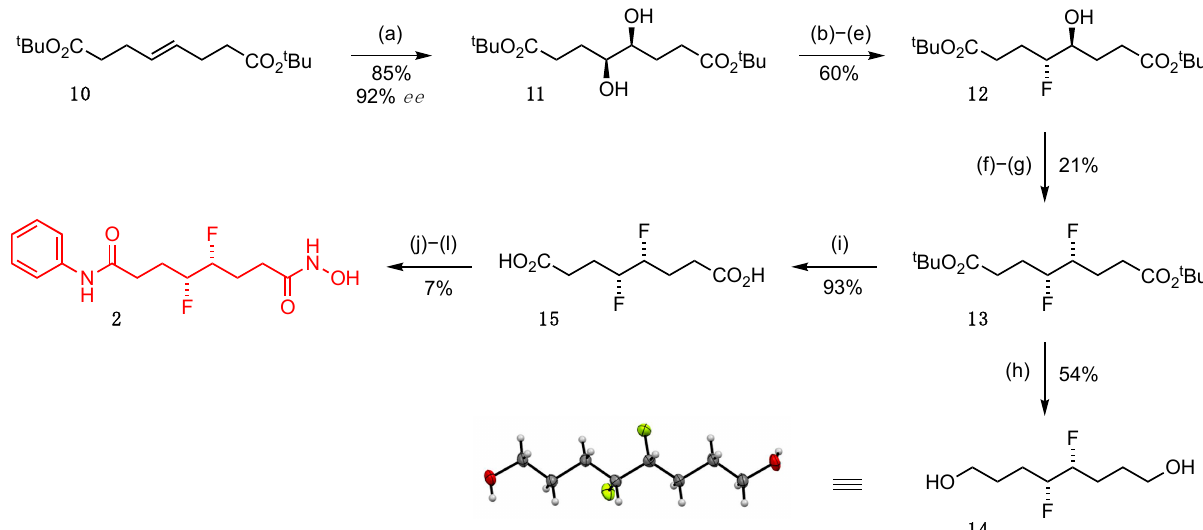
Scheme 1. Synthesis of threo -difluorinated SAHA analog 2 . Reagents and conditions: (a) K 2 OsO 4 , (DHQ) 2 PHAL,